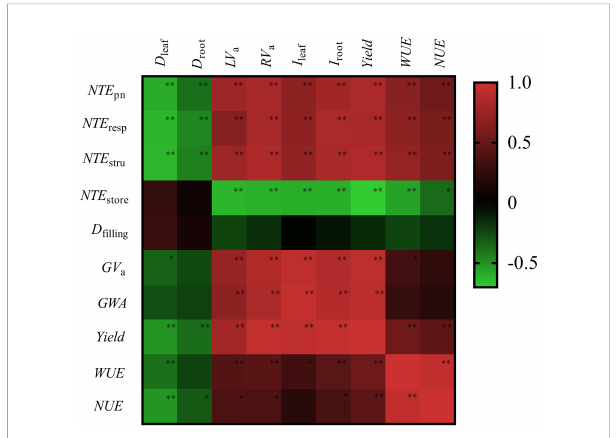
FIGURE 8 Heatmap of correlation coef fi cients between senescence traits, fi lling traits, yield, water, and N use ef fi ciency. D leaf , green leaf duration; D root , live root duration; LV a , average leaf senescence rate; RV a , average root senescence rate; I leaf , green leaf integral; I root , live root integral; D fi lling , grain fi lling duration; GV a , average grain fi lling rate; GWA , grain weight growth during fi lling. WUE, water use ef fi ciency. NUE, N use ef fi ciency. NUE pn , NTE resp , NTE stru , and NTE store are the translocation ef fi ciency of photosynthetic N, respiration N, structure N and storage N, respectively. * P < 0.05 and ** P <